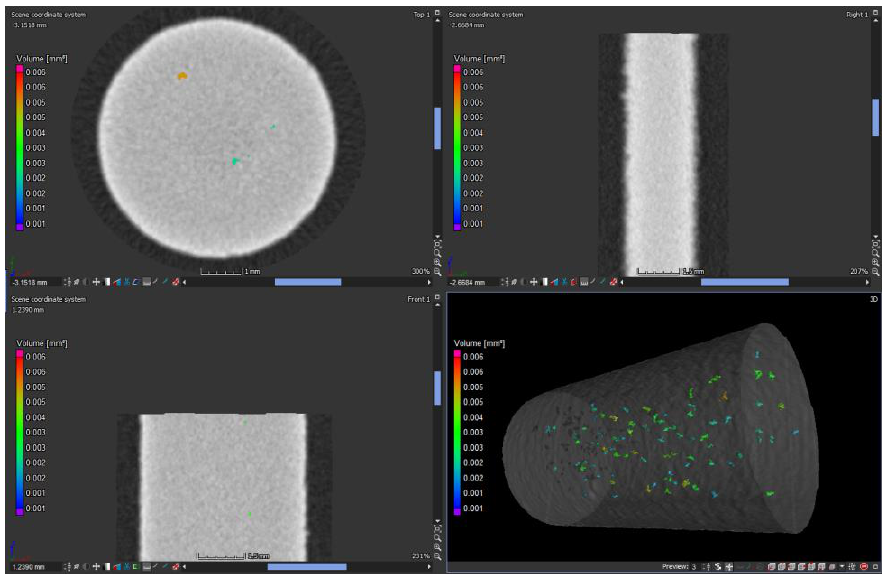
Figure 12. VGSTUDIO MAX 3.2 porosity analysis of the sample. Table 13. The resulting relative density of 3D printed samples after CT